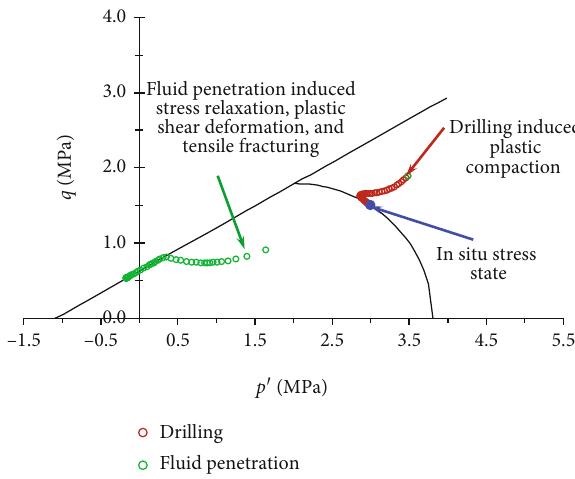
Figure 15: E ff ective stress paths experienced by a point on the wellbore surface during the drilling process and ensuing fl uid penetration process (no fl ow barrier and p m of 21.6